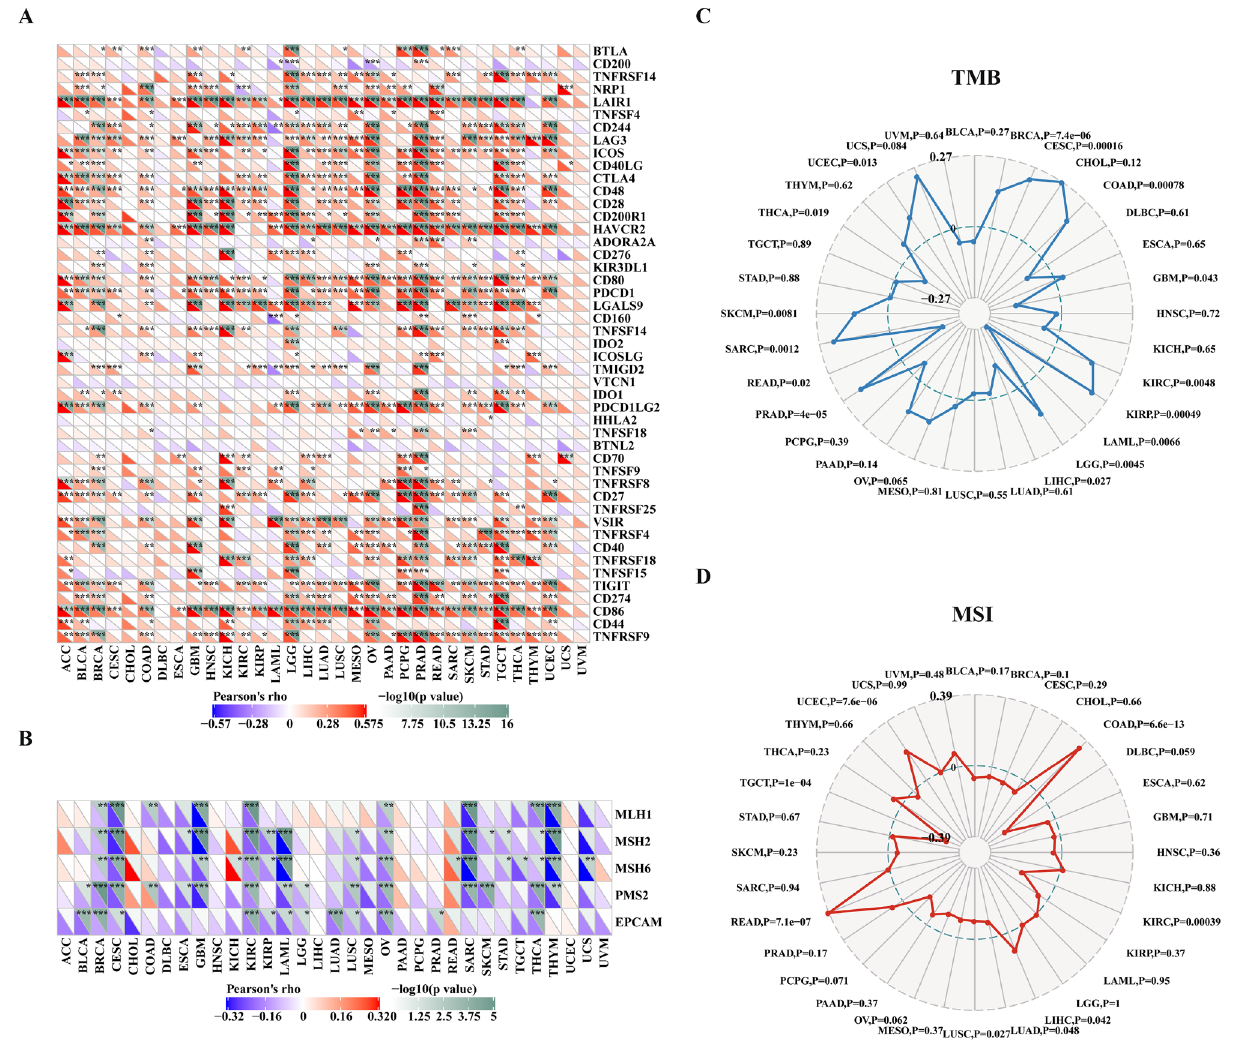
Figure 7. Relationship between immune checkpoints, DNA mismatch repair markers, TMB, MSI, and CD68 expression in pan-cancer. Correlation of CD68 expression with various immune checkpoints ( A ), DNA mismatch repair markers ( B ), TMB ( C ) and MSI ( D ) in pan-cancer. *P< 0.05, **P < 0.01, ***P <